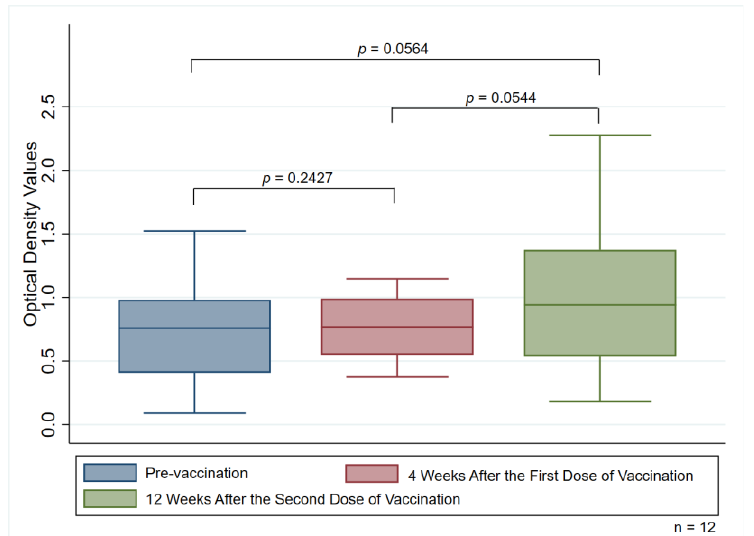
Figure 3. Median optical density values of anti-PF4 antibodies measuring pre-vaccination group, four weeks after the first dose, and 12 weeks after receiving the second dose of the vaccination among the 12 participants with detectable anti-PF4 antibodies.